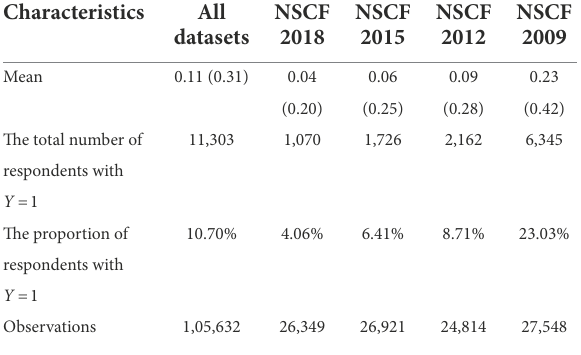
TABLE 7 The characteristics of variable Y.